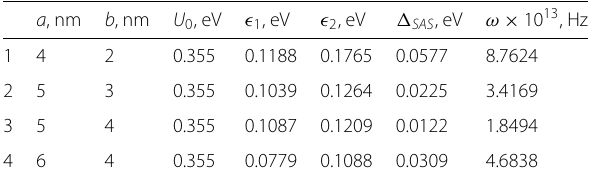
Table 1 Parameters of QW used in